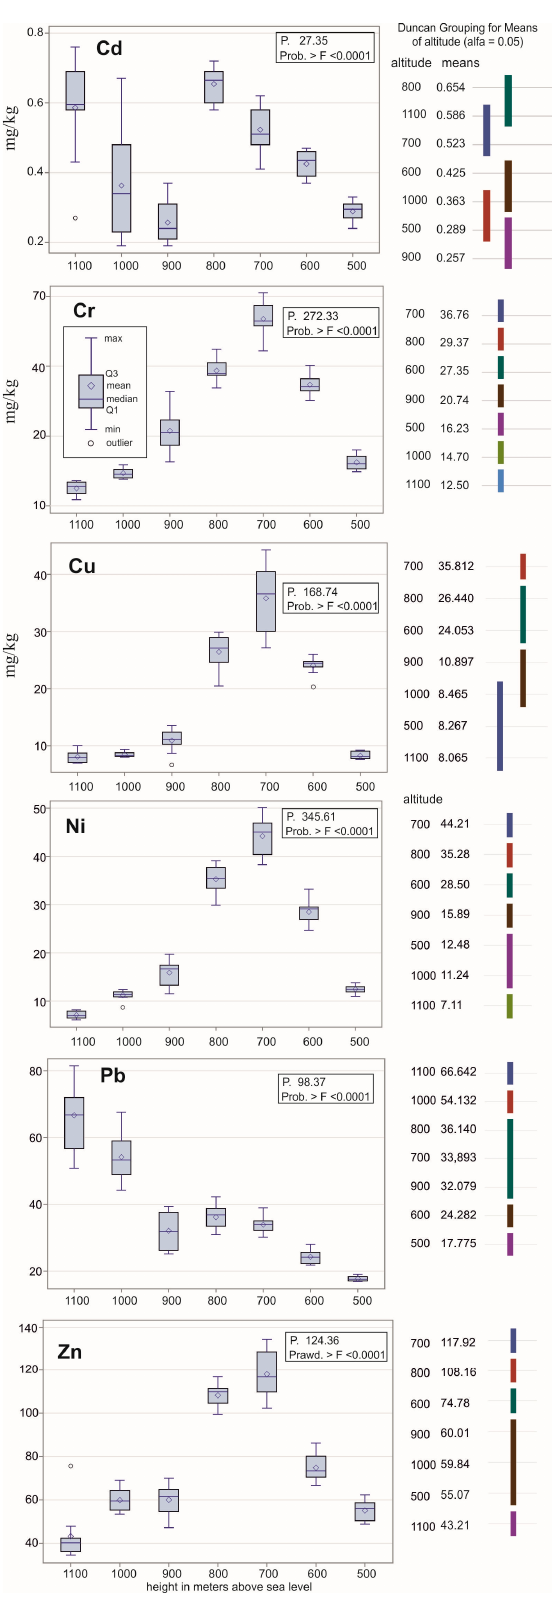
Figure 2. The content of metals in the soil according to altitude and the grouping of polygons according to the average content of elements in the soil.